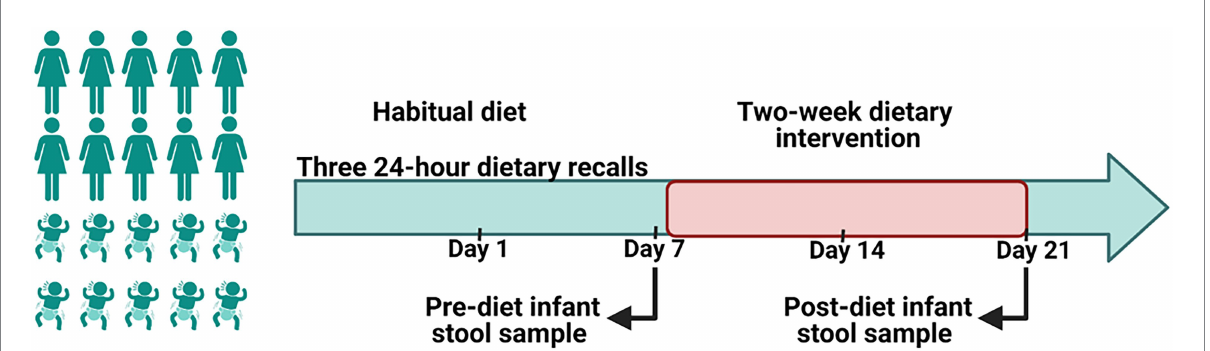
FIGURE 1 A schematic representation of the study design. A 2-week of a reduced fat and sugar maternal dietary intervention during lactation was performed to evaluate the effect of maternal diet on the infant gut microbiome. Before the intervention, mothers consumed their habitual diet, which was assessed using 24 h dietary recalls. During the intervention maternal dietary intake was analyzed using FoodWorks 10; Xyris Software. Infant stool samples were collected immediately prior to the intervention (baseline) and at the end of the